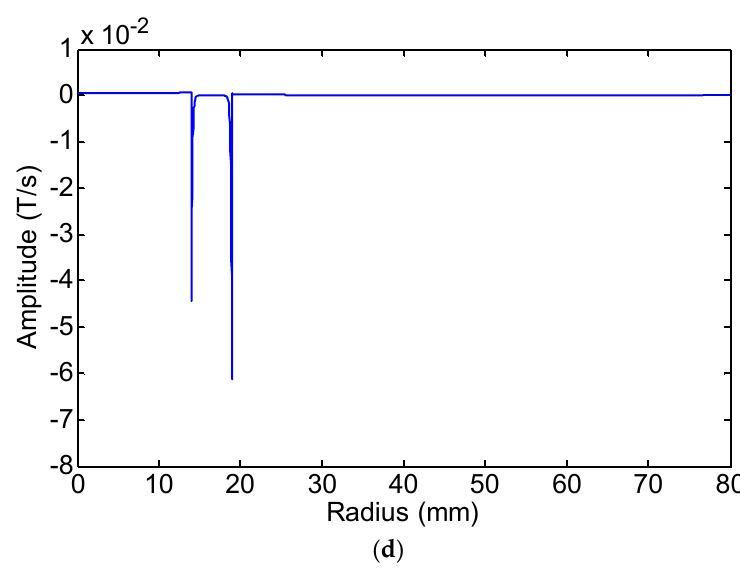
Figure 7. The FE calculation results of the changing rate of magnetic flux density in the radial direction at 80 kHz: ( a ) the internal air zone; ( b ) the pipe wall; ( c ) the external air zone; ( d ) the 0–80 mm zone.